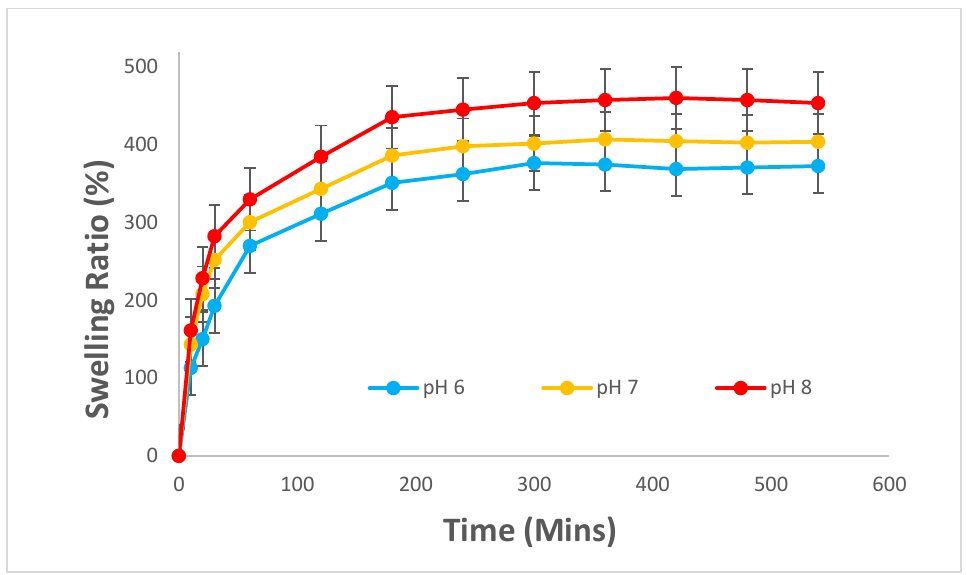
Figure 5. Swelling behaviour of BC-PAA at different pH values.